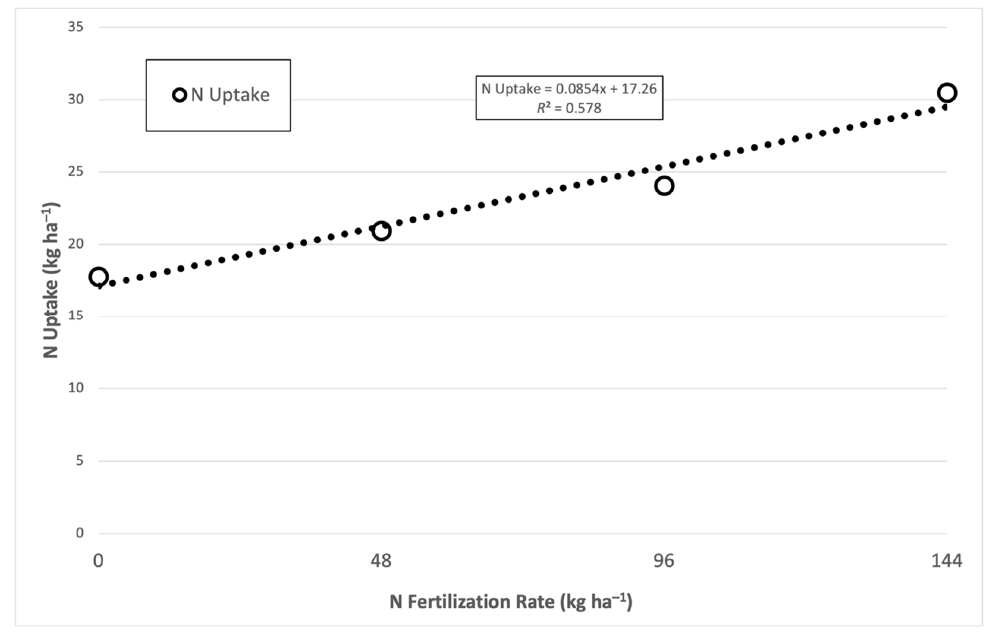
Figure 10. Mean N uptake in sweet corn as a function of N fertilization rate in 2020. Goodness of fit described with conditional R 2 .